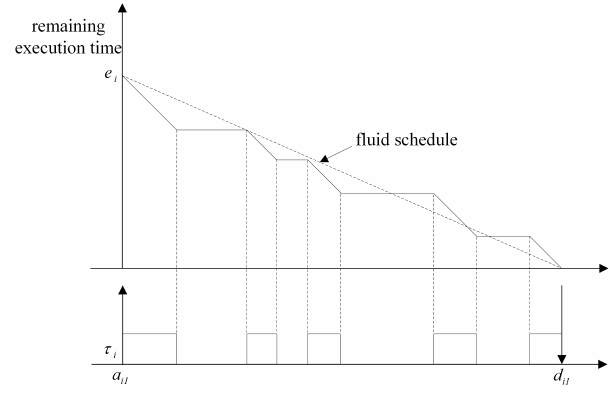
Figure 1. Fluid schedule model.